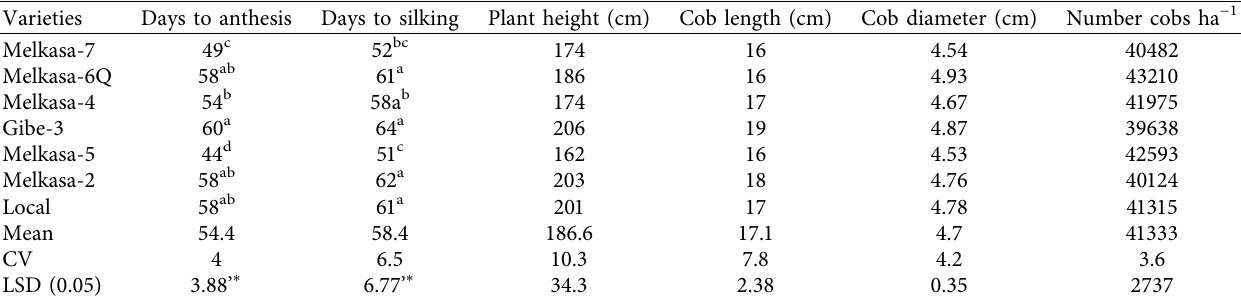
Table 4: Mean morphological and yield-related performance of open-pollinated maize varieties in 2017. Varieties